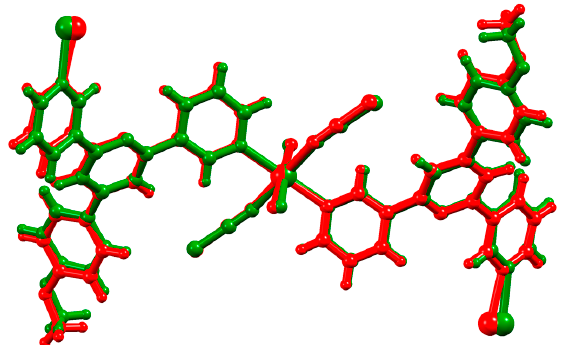
Figure 7. Overlay of the repeating units (with symmetry generated atoms) in [{Co( 2 ) 2 (NCS) 2 } . 3MeOH] n (shown in red) and [{Co( 2 ) 2 (NCS) 2 } . 2.2CHCl 3 ] n (in green). Solvent molecules omitted. The angles between the planes of connected pyridine rings are 32.9° and 32.0° in [{Co( 2 ) 2 (NCS) 2 } . 3MeOH] n and 33.8° and 38.2° in [{Co( 2 ) 2 (NCS) 2 } . 2.2CHCl 3 ] n ; the angle between the rings in the 4-methoxyphenylpyridine unit is 50.8° in [{Co( 2 ) 2 (NCS) 2 } . 3MeOH] n and 50.5° in [{Co( 2 ) 2 (NCS) 2 } . 2.2CHCl 3 ] n .